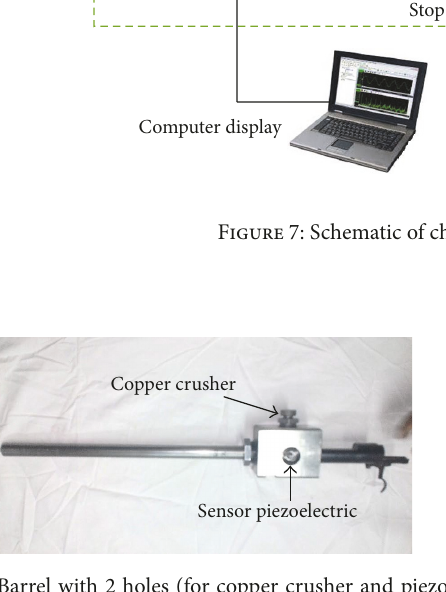
Figure 8: Barrel with 2 holes (for copper crusher and piezo pres- sure).